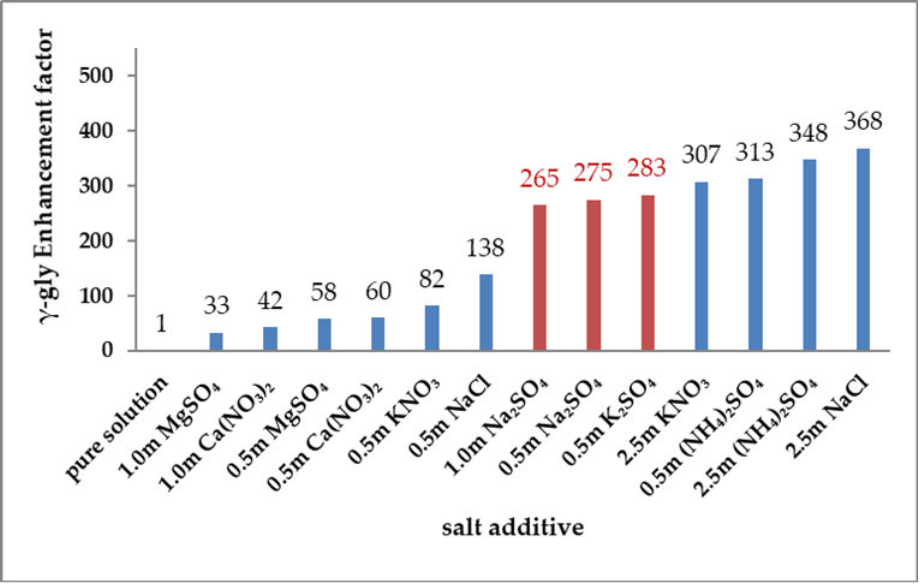
Figure 5. Salt-associated enhancement factors of γ-glycine secondary nucleation during solution-mediated polymorphic transformation (SMPT).